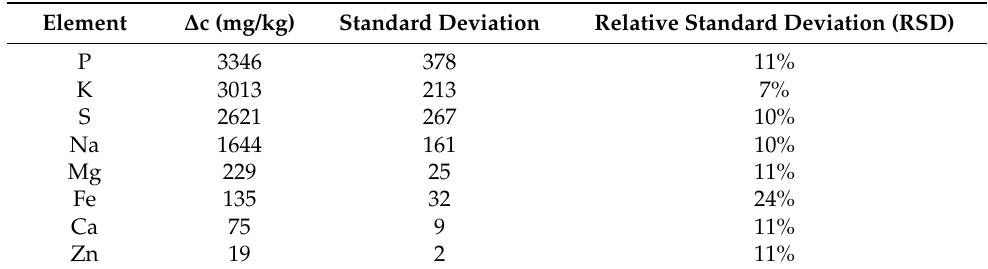
Table 1. Concentrations of selected elements in murine kidney measured by inductively coupled plasma-optical emission spectrometry (ICP-OES). Element ∆ c (mg/kg) Standard Deviation Relative Standard Deviation